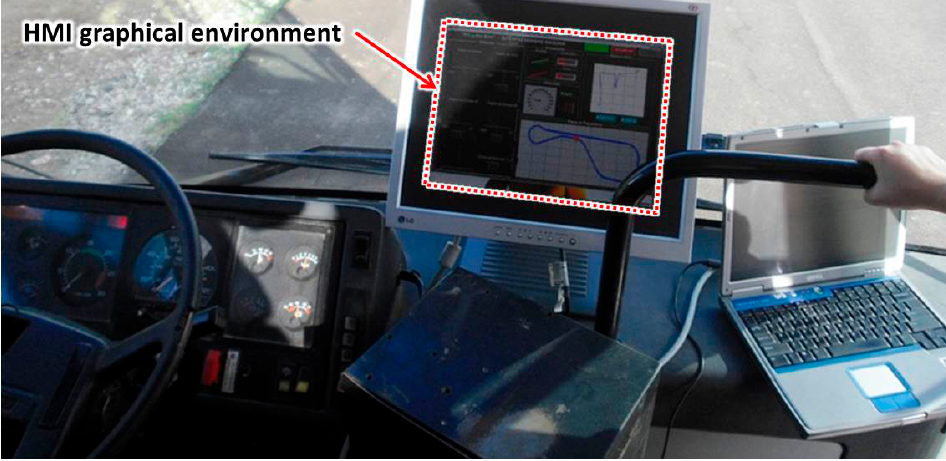
Figure 10. HMI graphical environment on board the bus during a test on the CSIC inner road.